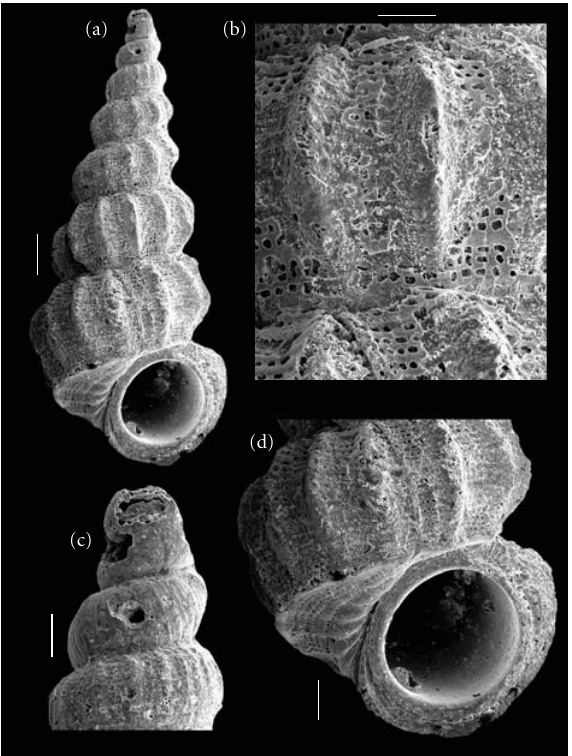
Figure 10: (a–d) Gregorioiscala pimentai new species (holotype— MNRJ 18.306); (a) ventral view, (b) detail of teleoconch ornamen- tation, (c) protoconch, and (d) view of last whorl. Scale bars: